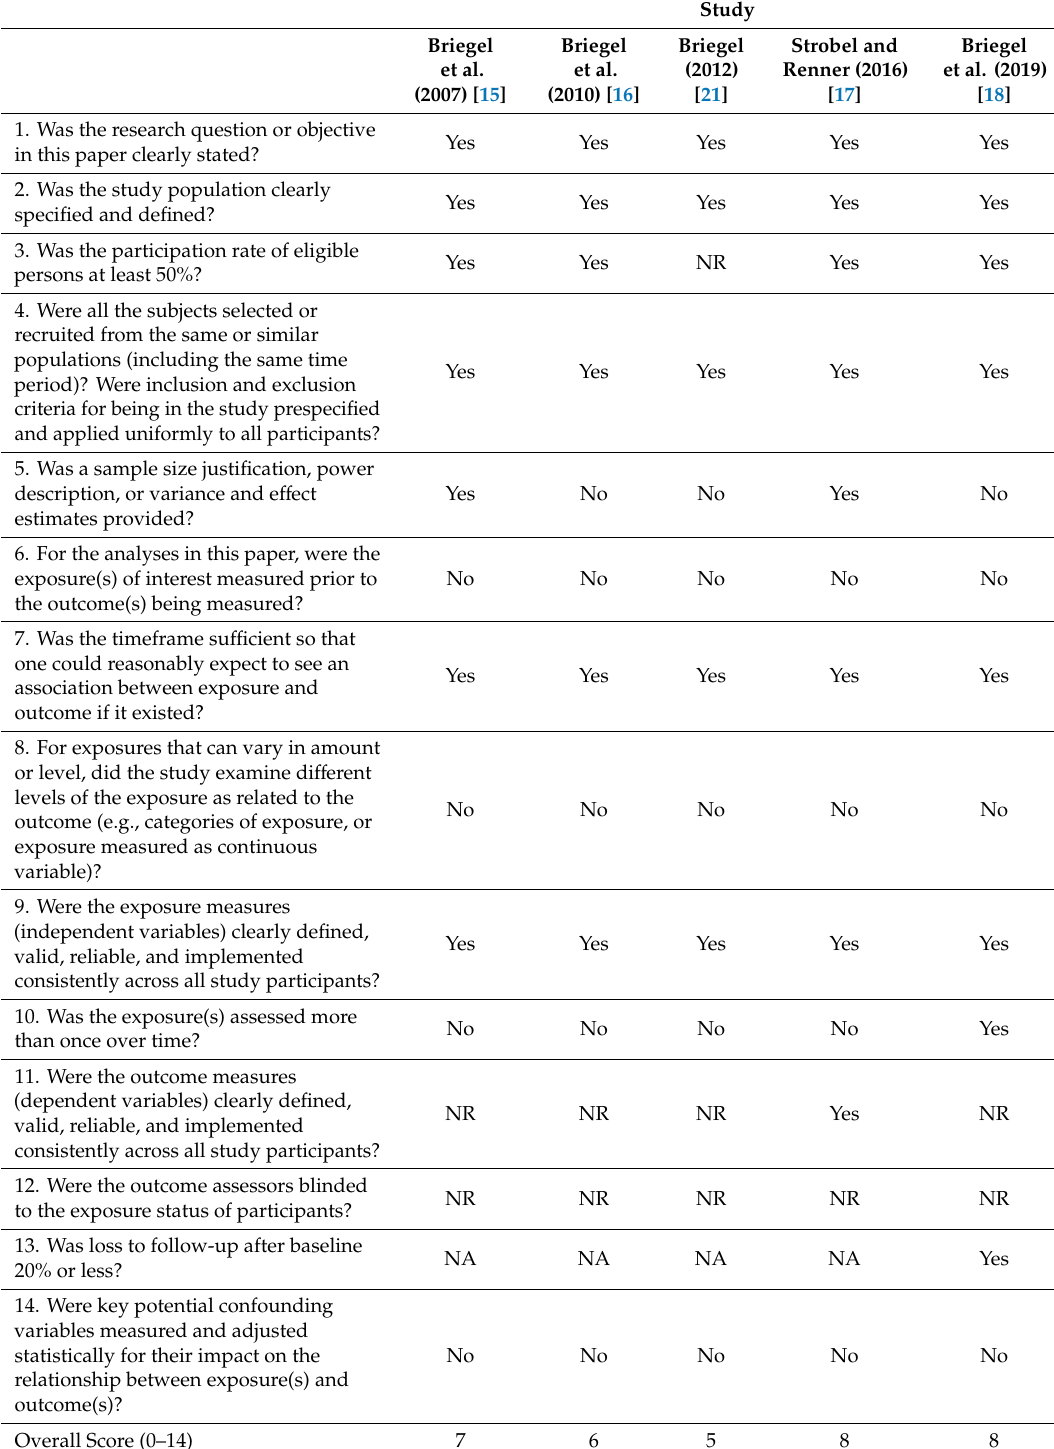
Table 4. Risk of bias for included studies (NIH quality assessment tool for observational cohort and cross-sectional studies; National Institutes of Health,